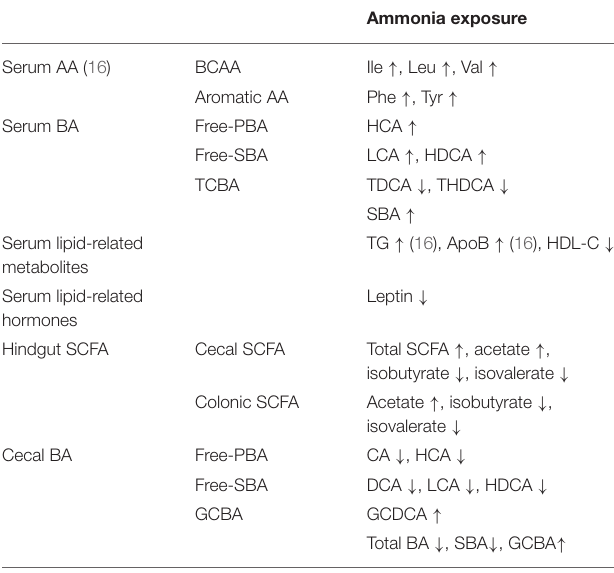
TABLE 1 | Summary of the altered metabolites from host serum or hindgut chyme after high ammonia